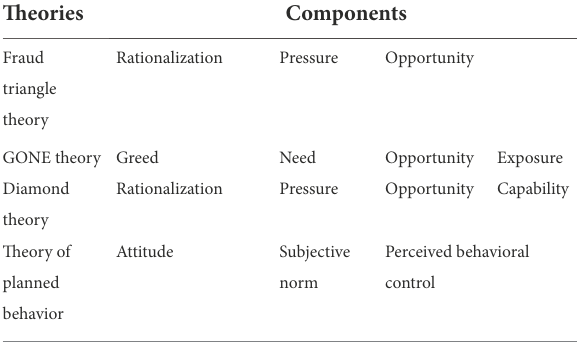
TABLE 1 Comparison of components of fraud motivation theories.